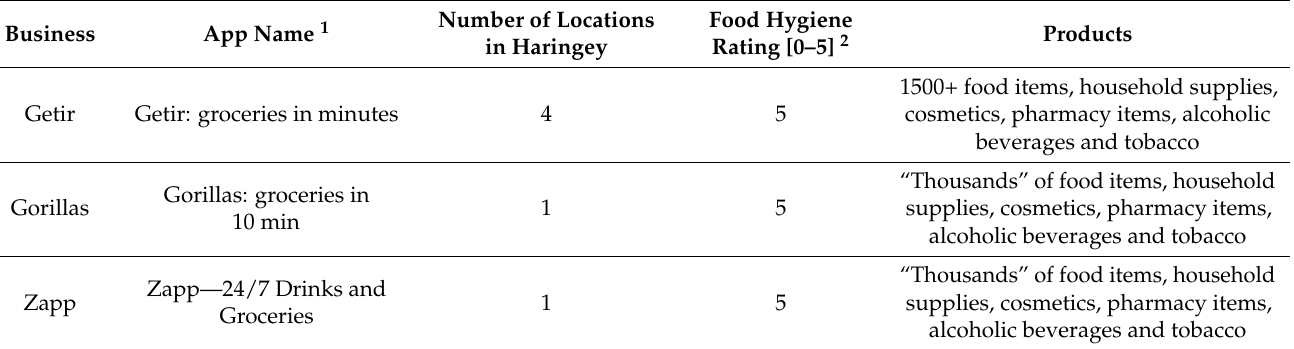
Table 2. Dark grocers in the London Borough of